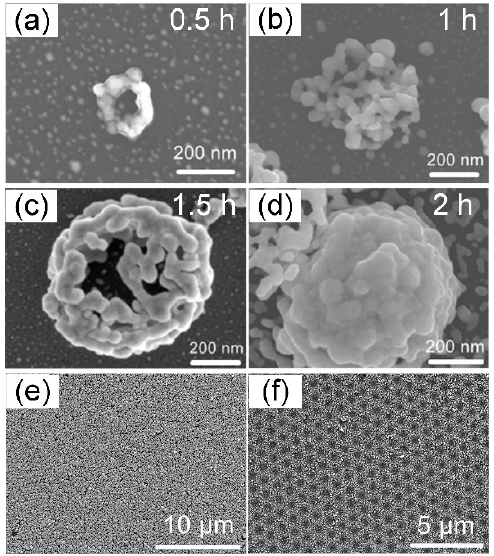
Figure 2. Observation of silver nanoclusters fabricated by laser near-field reduction. ( a – d ) SEM images of single silver nanocluster fabricated by CW laser near-field reduction with reduction times of 0.5, 1, 1.5, and 2 h after silica microsphere elimination. ( e ) Low magnification SEM image of plasmonic hollow nanocluster array with a period of 500 nm. ( f ) Crater array formation on a silicon substrate due to silica microspheres shielding against silver nanoparticle deposition. Silver nanoparticles grow along the surfaces of the silica microspheres; therefore, the period of the nanocluster array can be easily adjusted using different diameters of silica microspheres. For example, Figure 3a,b show nanoclusters formed on loosely assembled silicon microspheres with diameters of 500 nm and 1000 nm, respectively, where the sizes of the nanoclusters coincide with those of the silicon microspheres. Different periods of plasmonic superstructure arrays can thus be fabricated, as shown in the Figure 4a,b and Supplementary Material, Figure S6. The energy dispersive X-ray spectroscopy (EDS) map- ping images shown in Figure 3d,e, and the corresponding SEM image (Figure 3d) indicate that the nanoclusters are composed of pure silver. Figure 3. Morphology of silver nanocluster with different sizes. Silver nanocluster with sizes of ( a ) 500 nm, ( b ) 1000 nm, and ( c ) 2000 nm. ( d ) Magnified SEM image of five silver nanoclusters with a size of 500 nm, and corresponding EDS maps for ( e ) silver and ( f ) silicon.